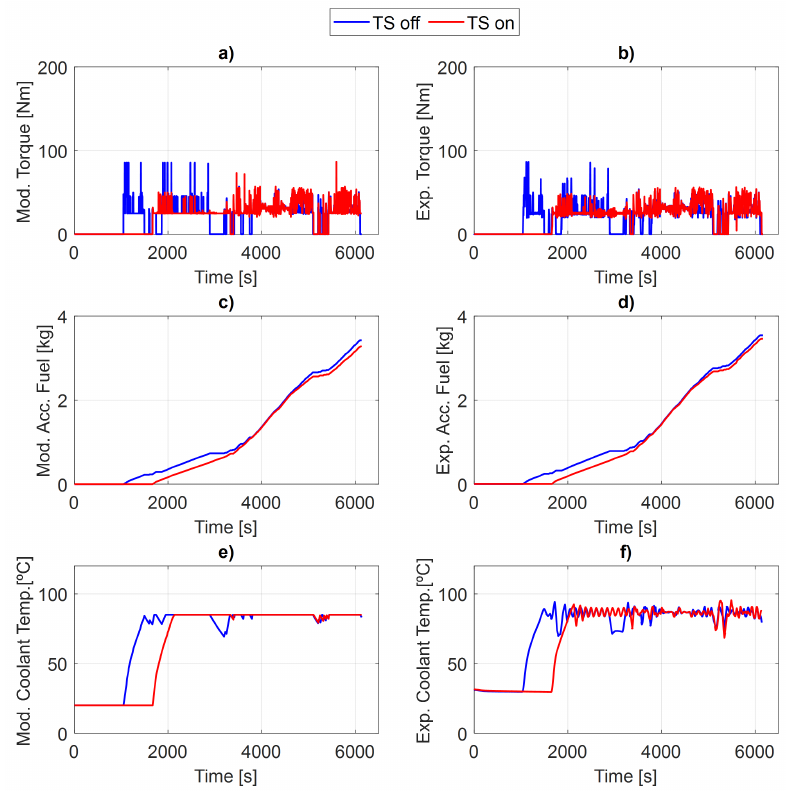
Figure 14. Comparison between both strategies for ICE simulation results (left plots) and experimental measurements (right plots) during the RDE cycle. ( a ) Model torque. ( b ) Experimental torque. ( c ) Model fuel consumption. ( d ) Experimental fuel consumption. ( e ) Model coolant temperature. ( f ) Experimental coolant